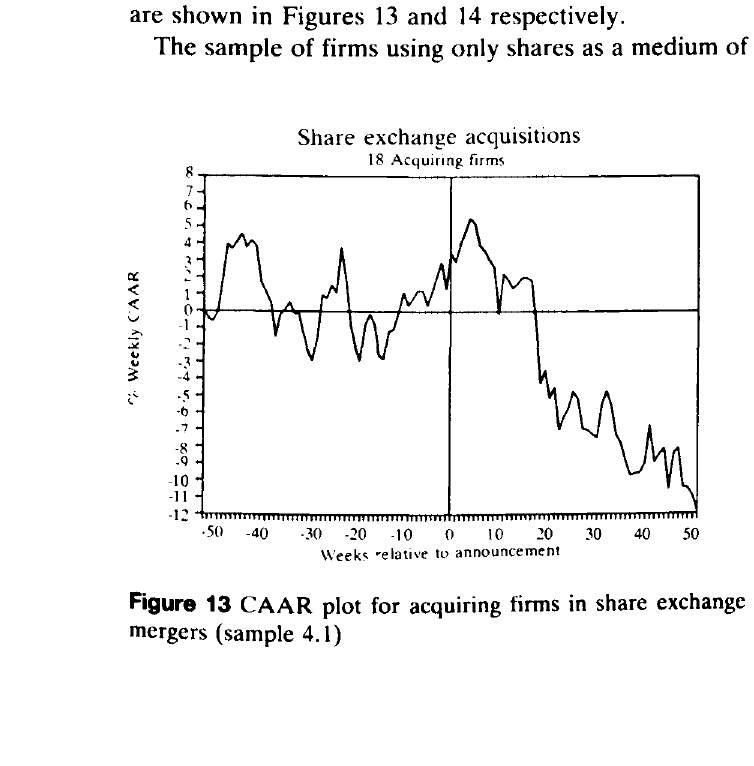
Figure 13 CAAR plot for acquiring firms in share exchange mergers (sample 4.1)